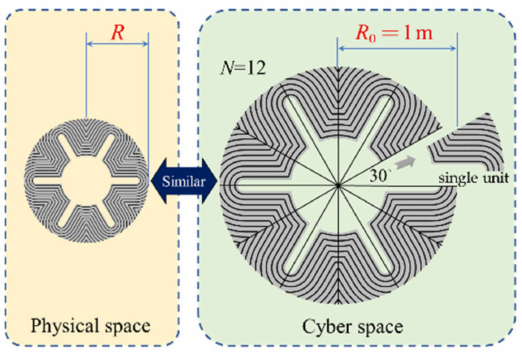
Figure 3. Illustration of the similar